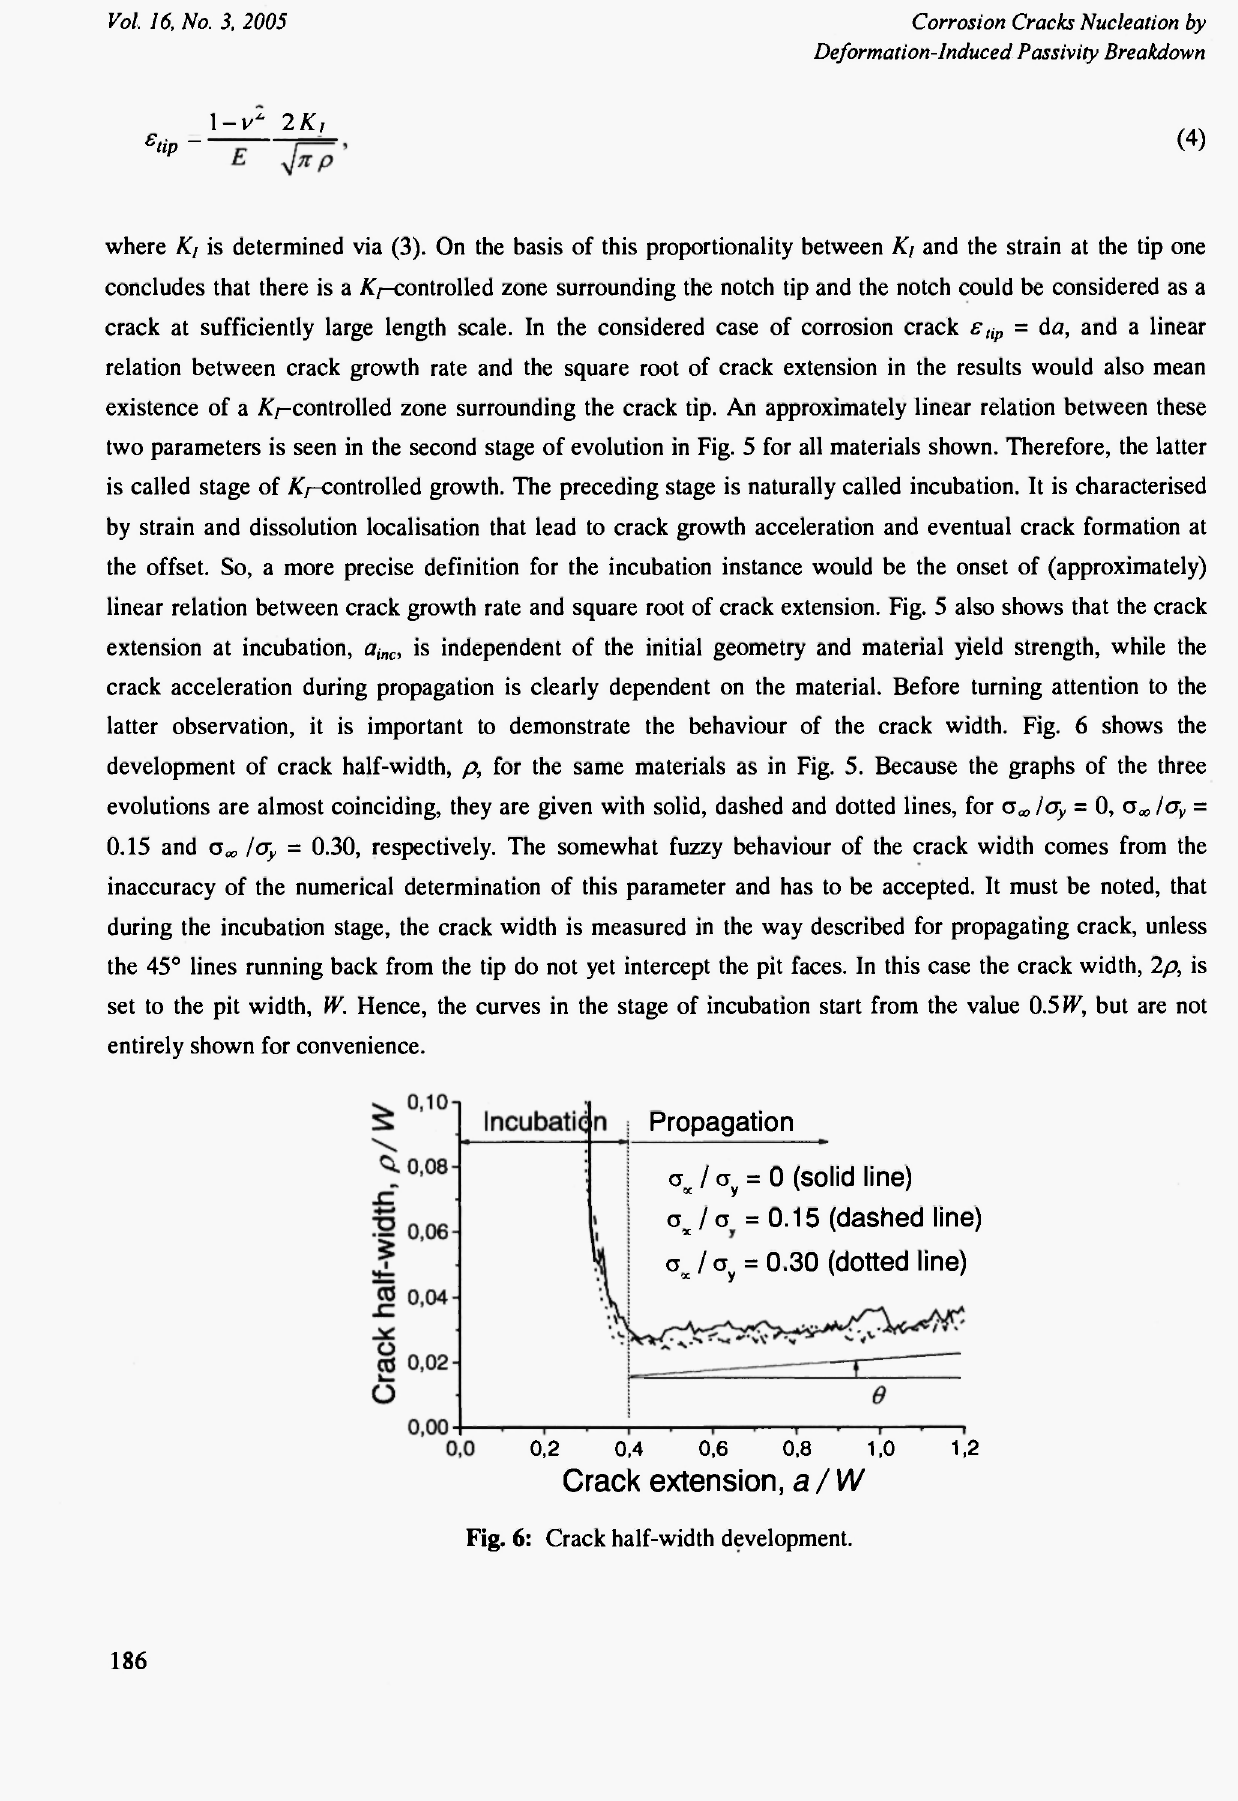
Fig. 6: Crack half-width